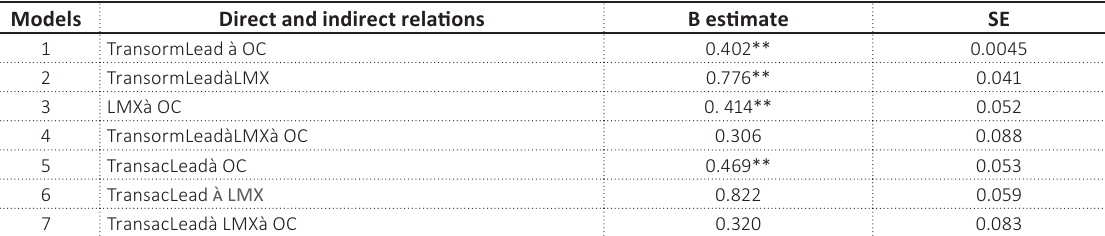
Table 6. Unstandardized coefficients for research models Models